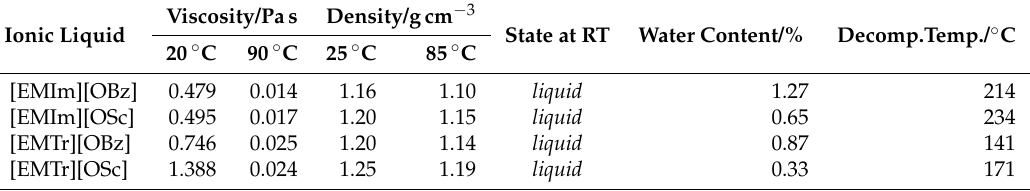
Table 1. Experimentally determined viscosity, density, water content, and decomposition temperature (5% weight loss) of the ionic